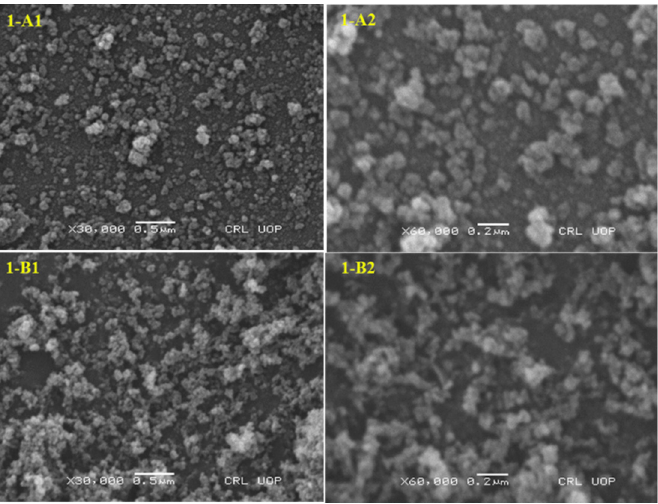
Figure 4. An SEM micrograph of Fe 3 O 4 nanoparticles ( 1-A ) and related SiO 2 nanocomposites ( 1-B ) (calcined at 500 °C) at different resolutions.